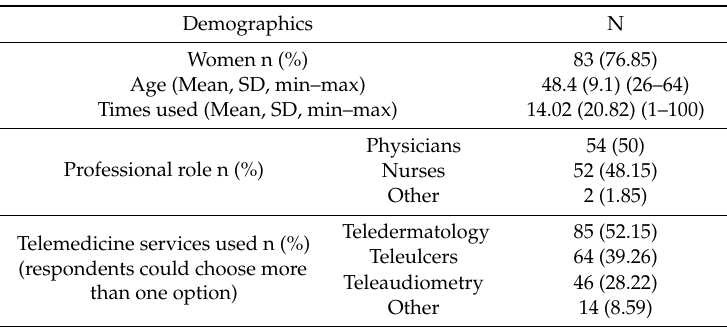
Table 1. Sample Characteristics.